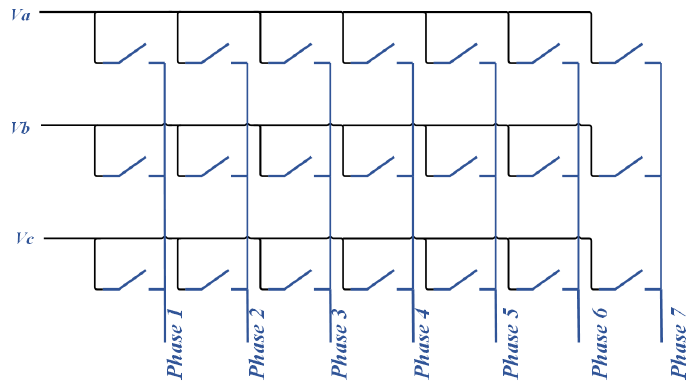
Figure 28. The topology of 3 × 7 matrix converter.